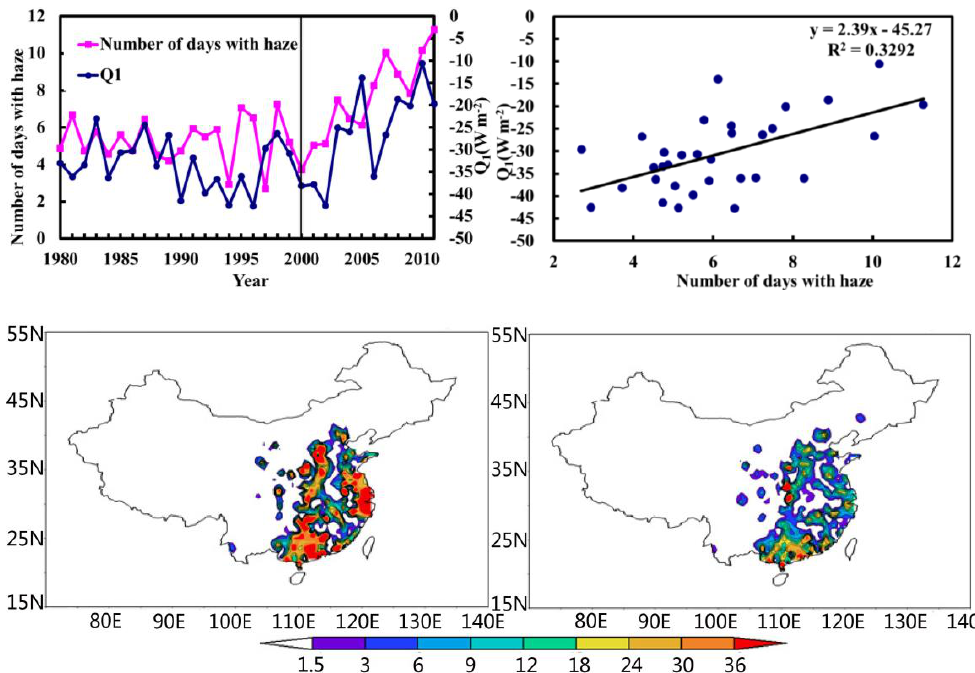
Figure 4. Interannual variability in the apparent heat source Q 1 (the negative values denote cooling) integrated vertically over the TP and haze event frequency averaged in the CEC in winter (December, January and February) over 1980–2012 and their correlation (upper panel). The haze frequencies (days) averaged in five winters with most positive (lower left panel) and most negative Q 1 anomalies (lower right panel) on the TP relative to the mean haze frequency from 1980 to